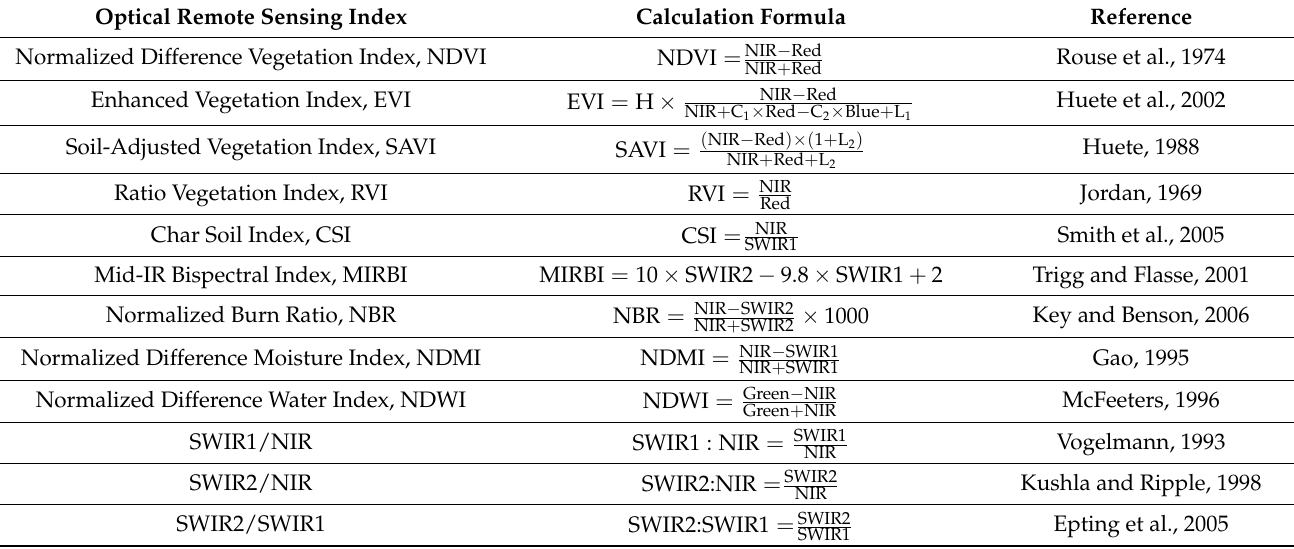
Figure 1. Flow chart of angle effect evaluation on typical optical remote sensing indices in vegeta- tion monitoring. Table 1. Optical remote sensing